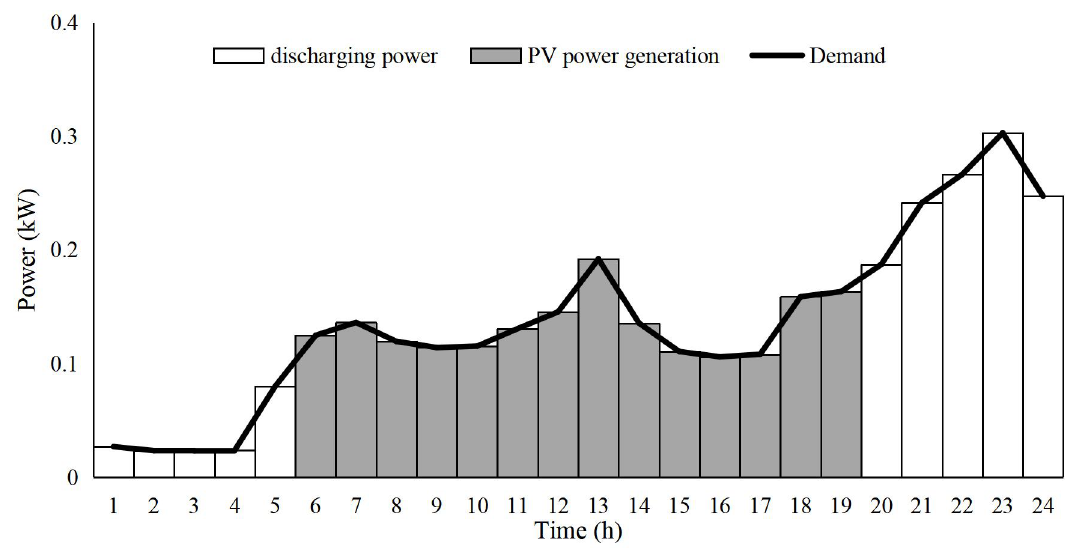
Figure 7. The power balance of the PV system in Case I in Zone 1 on a non-summer day.